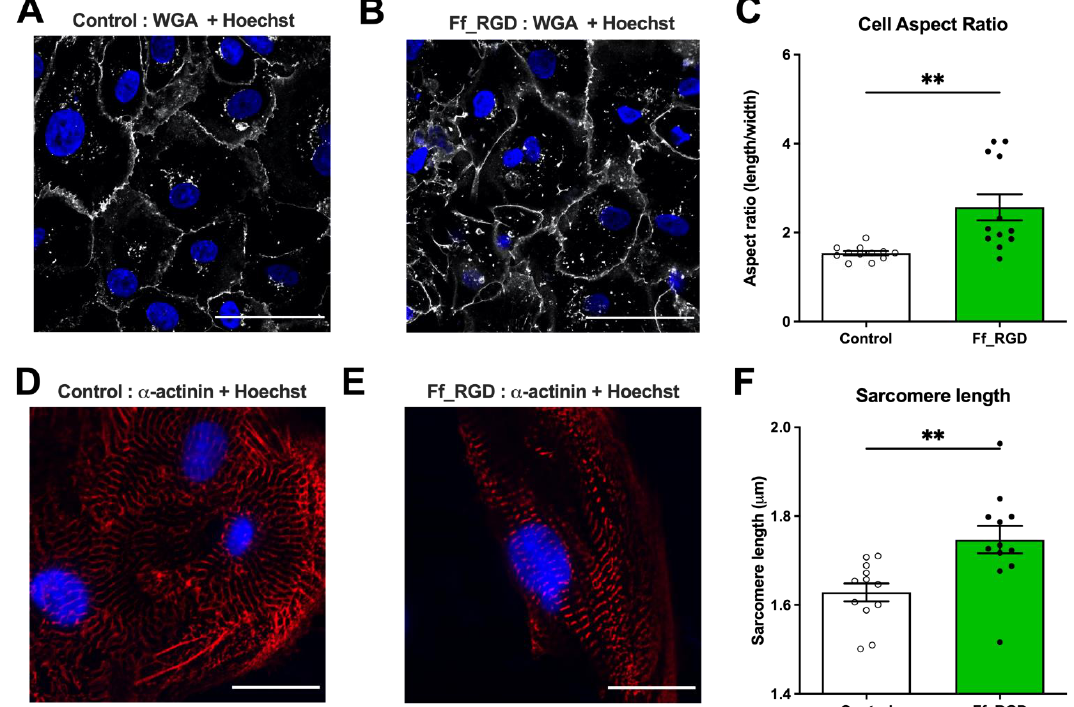
Figure 3. Integrin ligand ff_RGD induces changes in cardiomyocyte structure. Cardiomyocytes at day 40 – 46 of differentiation were treated for 24 h with ( A ) control or ( B ) ff_RGD. Representative confocal images with wheat germ agglutinin (WGA) (white) and Hoechst (blue) staining. Scale bar = 50 μm. Confocal images were used to investigate the ( C ) aspect ratio (** p = 0.0021) illustrated as means ± SEM ( n = 12 control, n = 12 ff_RGD images from three batches. Each data point is an average of the cellular values within the field of view. Hoechst (blue) and α− sarcomeric actinin (red) staining of ( D ) control and ( E ) ff_RGD − treated cardiomyocytes. Scale bar = 50 µ m. α −